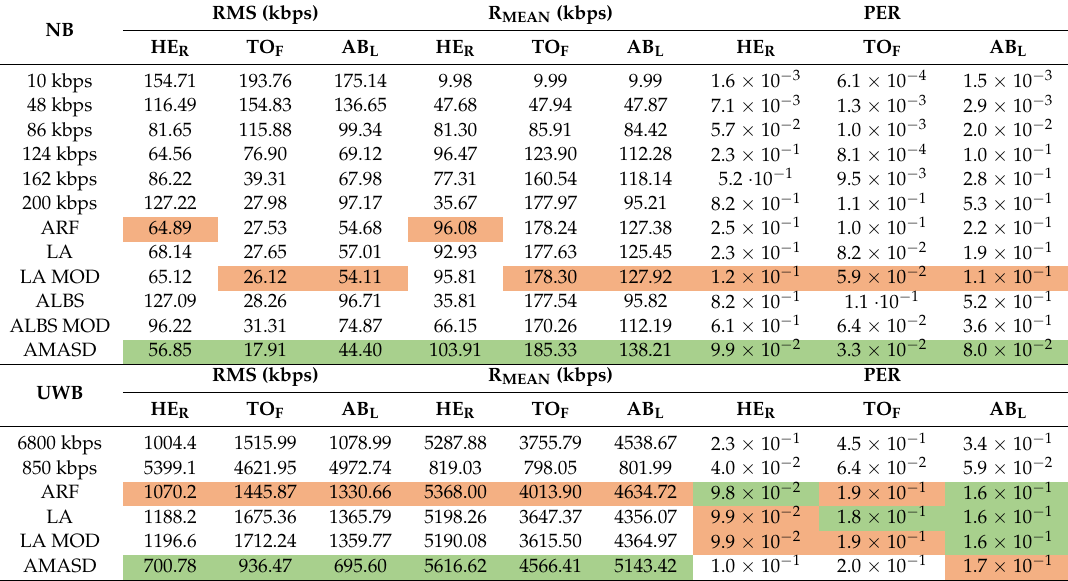
Table 5. Numerical results of the available time-frequency resources usage. RMS (kbps) R MEAN (kbps) PER NB HE R TO F